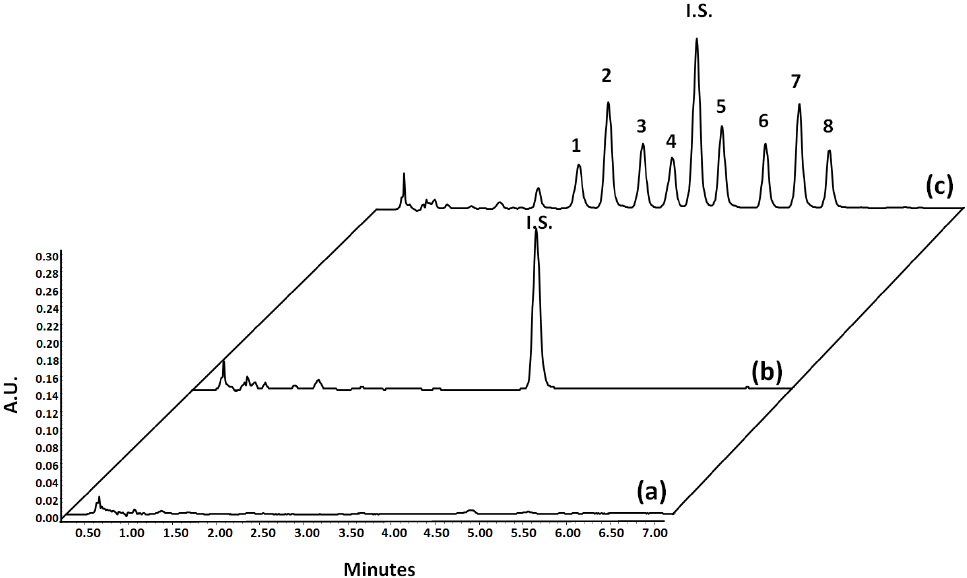
Figure 11. UHPLC chromatograms of blank plasma extracted ( a ), blank plasma spiked with I.S. ex- tracted ( b ), blank plasma spiked with levofloxacin (1), lomefloxacin (2), enrofloxacin (3), ciprofloxacin (4), gatifloxacin (5), sparfloxacin (6), sarafloxacin (7), and danofloxacin (8), and the I.S. extracted ( c ).